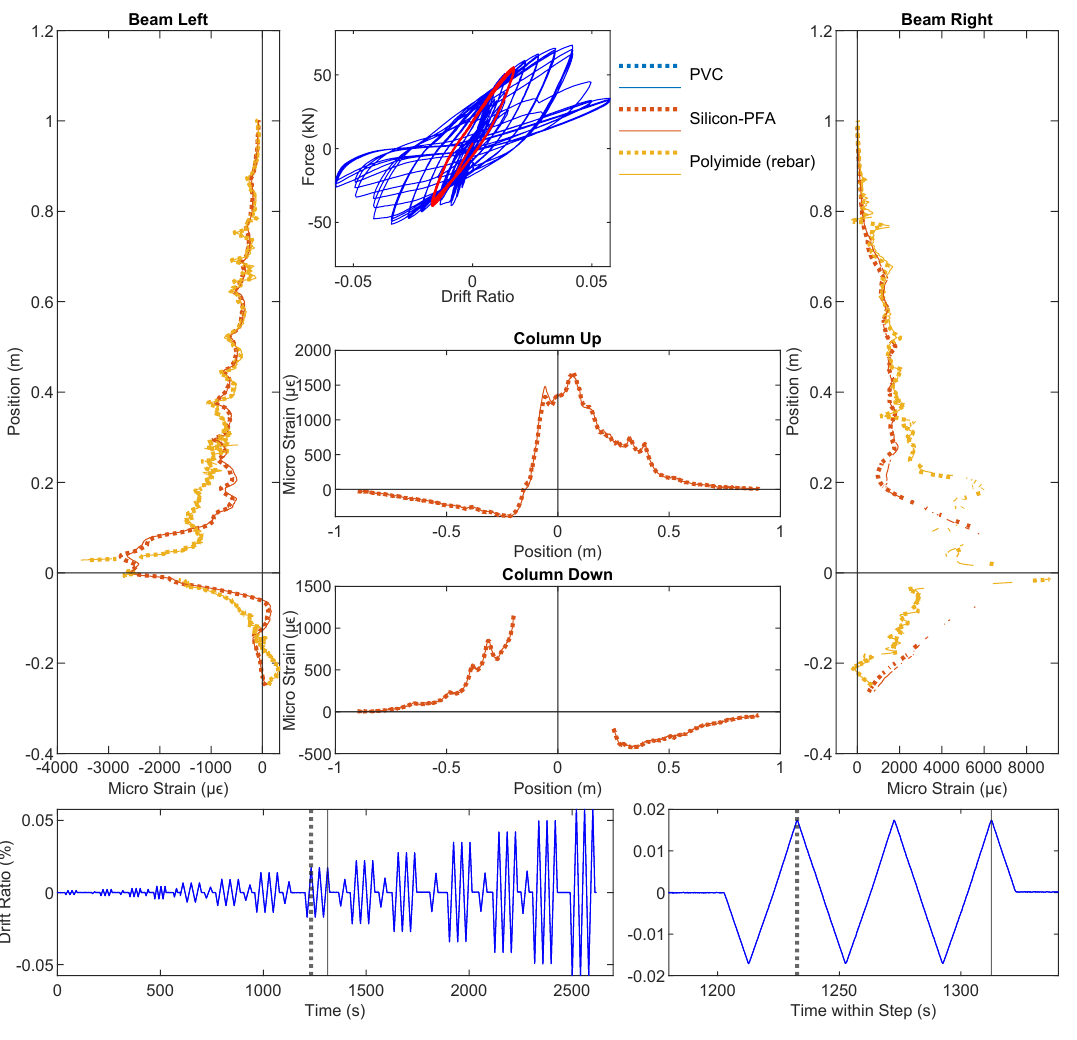
Figure 12. DFOS results at a drift level of